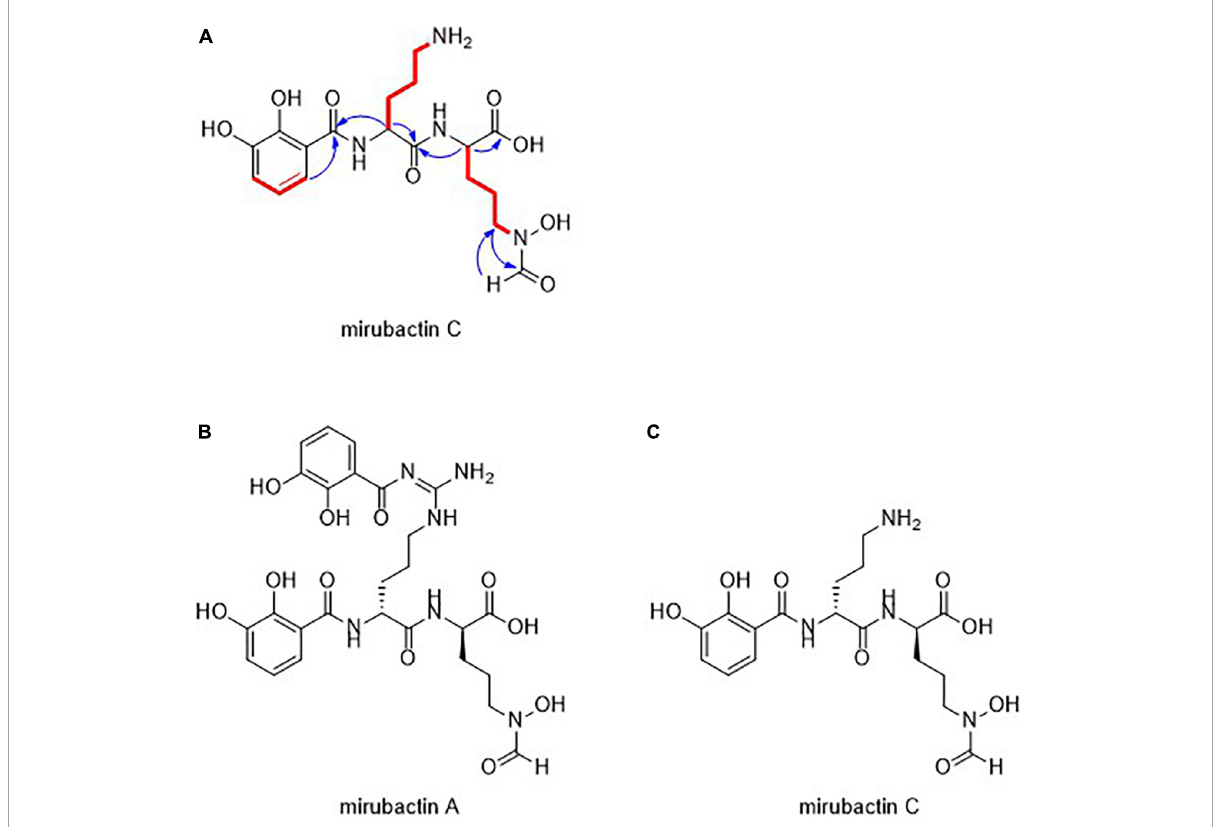
FIGURE1 (A) Structural assignment of mirubactin C (COSY = red, selected HMBC = blue) (B) Structures of mirubactin A (C) mirubactin C.